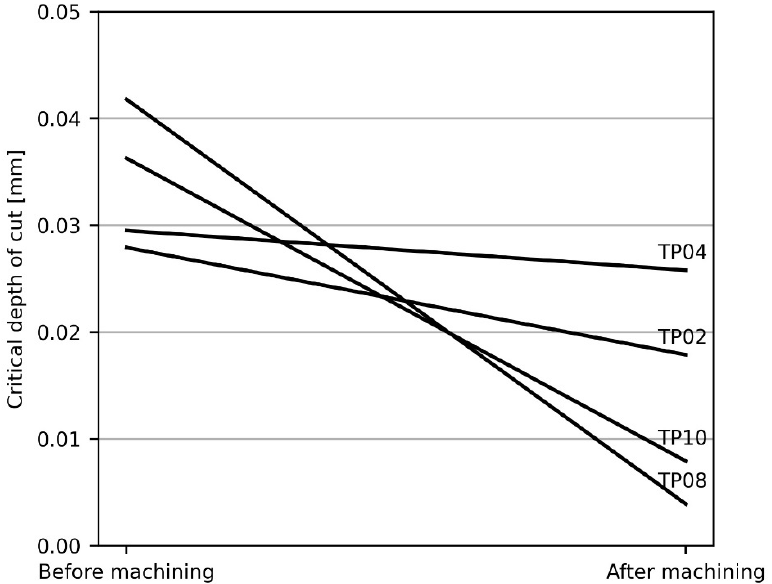
Figure 6. Critical axial depth of cut for the machining of each sample for different material removals.